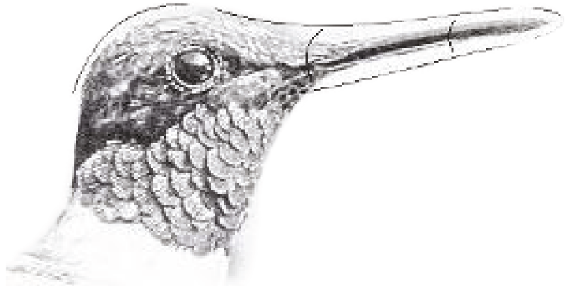
Figure 4: Streamline head type of the hummingbird type.